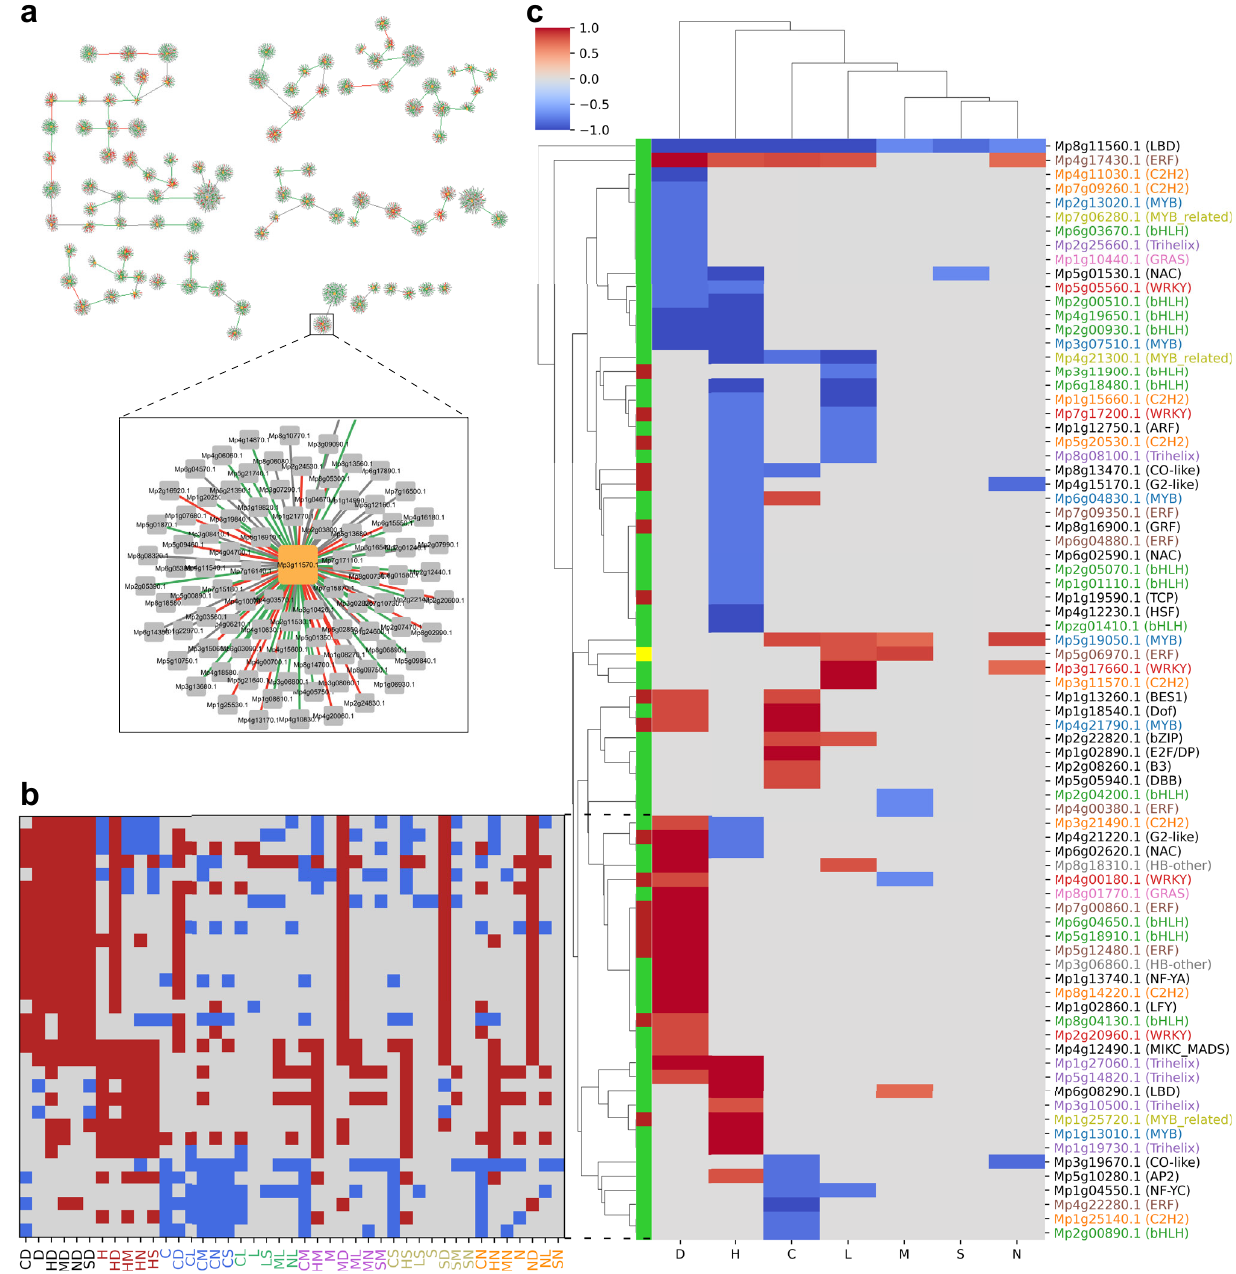
Fig. 3 | Identi fi cation of robustly-responding transcriptional activators and repressors. a Gene regulatory network constructed from the union of the seven stress-speci fi c networks. For each of the 6257 differentially expressed genes, we kept models with R 2 >0.8 and selected one TF with the highest absolute rela- tivecoef fi cient.OrangeandgraynodesrepresentTFsandgenes,respectively,while green and red edges represent positive and negative coef fi cients, respectively. b Differential expression patterns of TFs across stress groups. Red, blue, and gray indicatesigni fi cantlyup-,down-regulated,andunchangedexpression,respectively. Stresses are colored according to the stress groups. c Identi fi cation of 75 robustly-